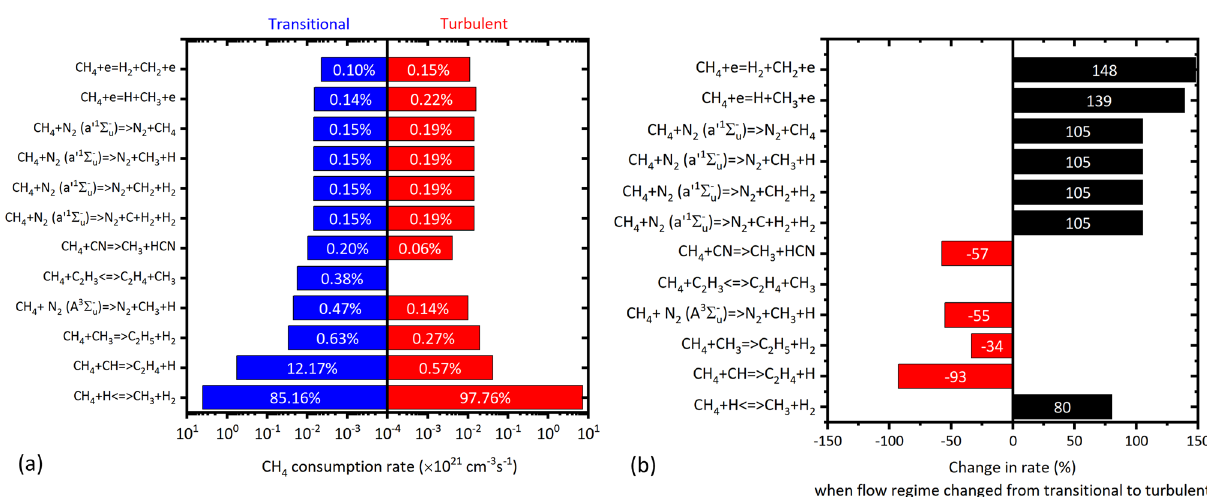
Figure 7. ( a ) Dominant reactions and their rates, with a relative contribution higher than 0.1% (shown as label) in the total consumption rate at transitional and turbulent flow regimes. ( b ) The % change in the rate of the dominant reactions due to flow regime